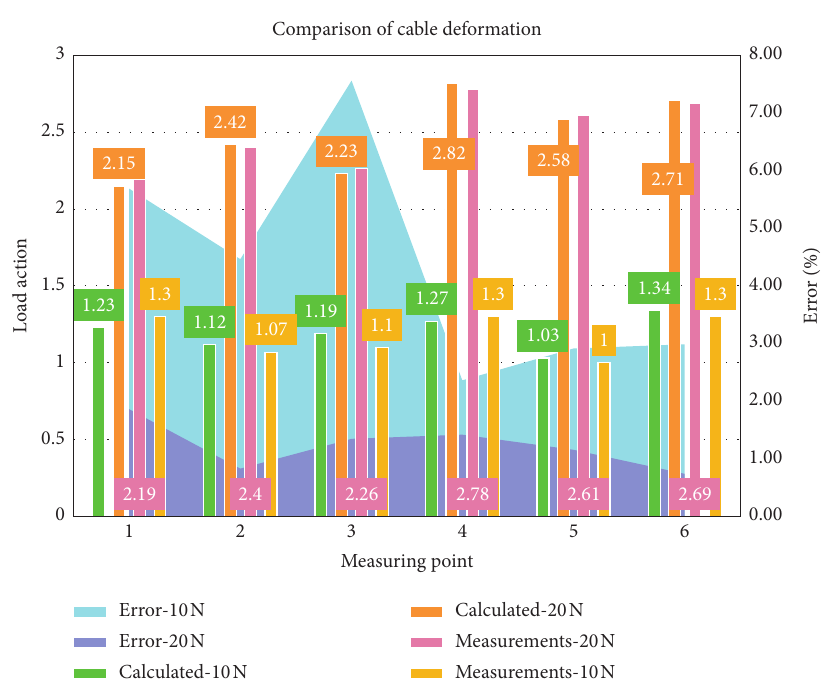
Figure 4: Comparison of deformation of bridge cables. Table 5: Accuracy statistics of measuring